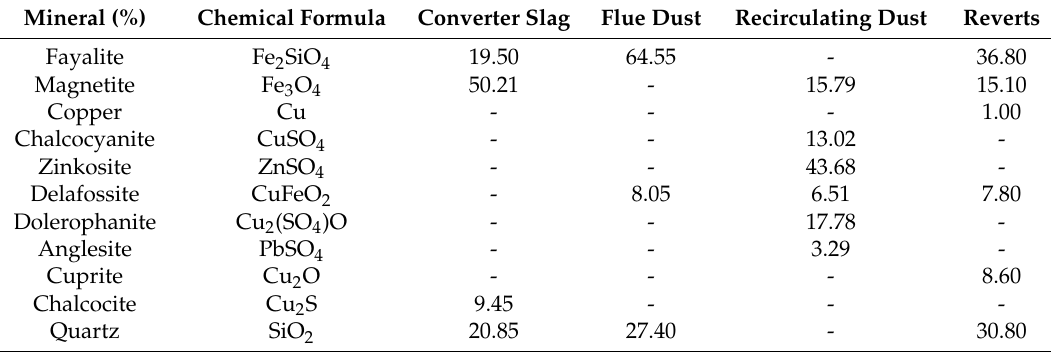
Table 6. Mineral composition of the recirculating